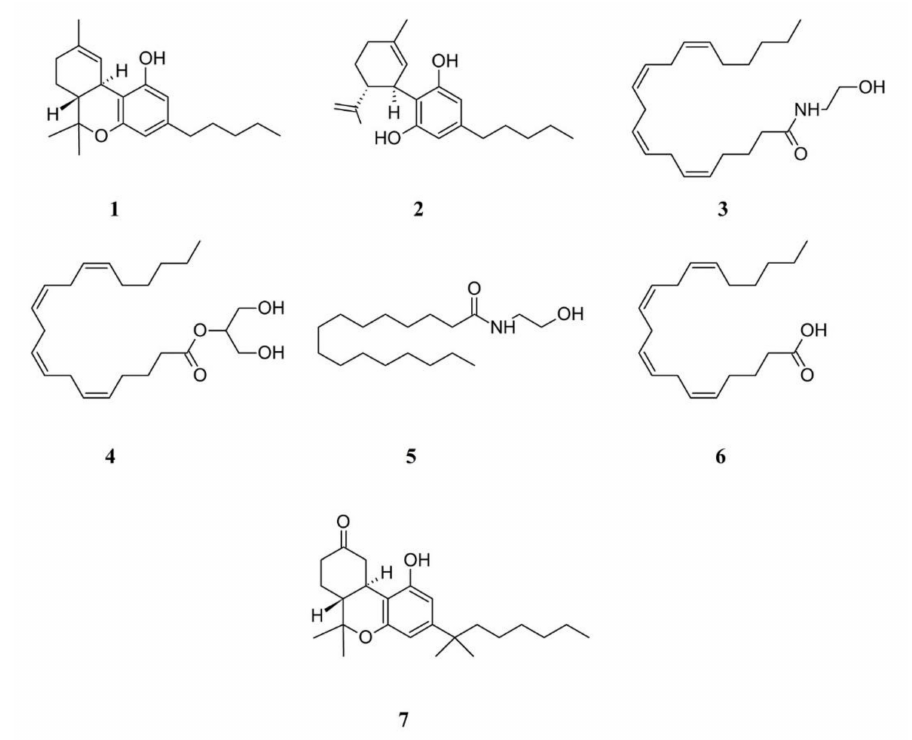
Figure 3. Structure formulae of some cannabinoids and related compounds. Numbers correspond to compound names cited in the